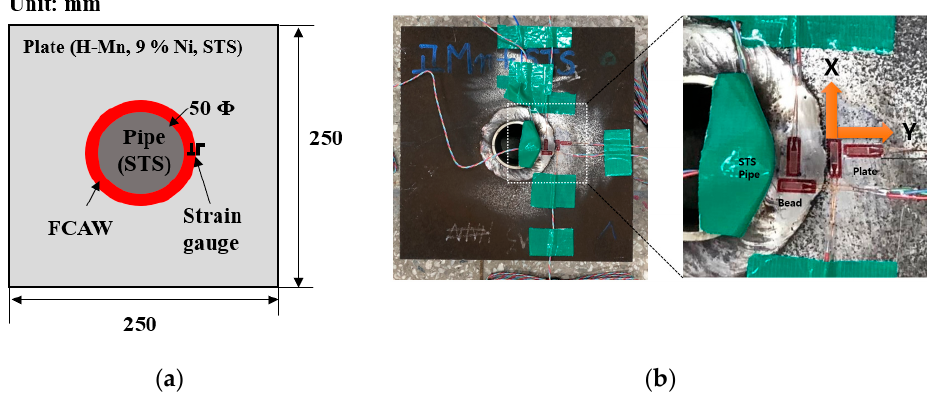
Figure 2. Location of strain-gauge attachment: ( a ) schematic and ( b ) specimen photograph used to measure the stress history in the loading and unloading conditions.